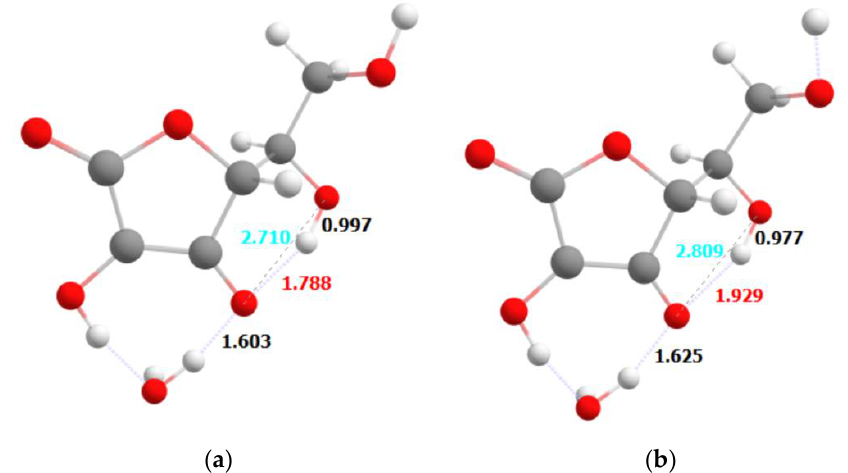
Figure 7. The optimized geometry of the deprotonated form of the ascorbic acid in its ground state ( a ) and first excited state ( b ). ( a ) and first excited state ( b